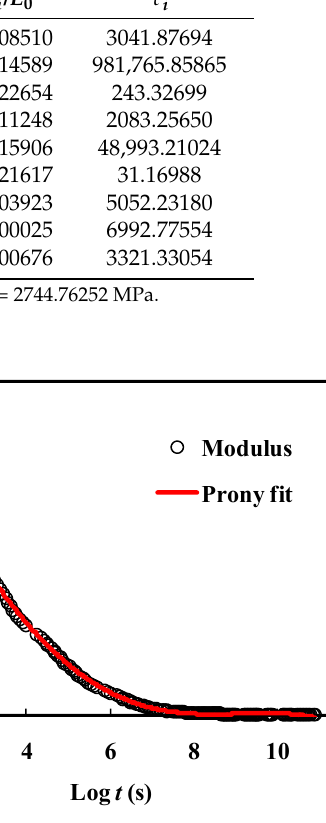
Figure 5. Prony series fitted to master curve.